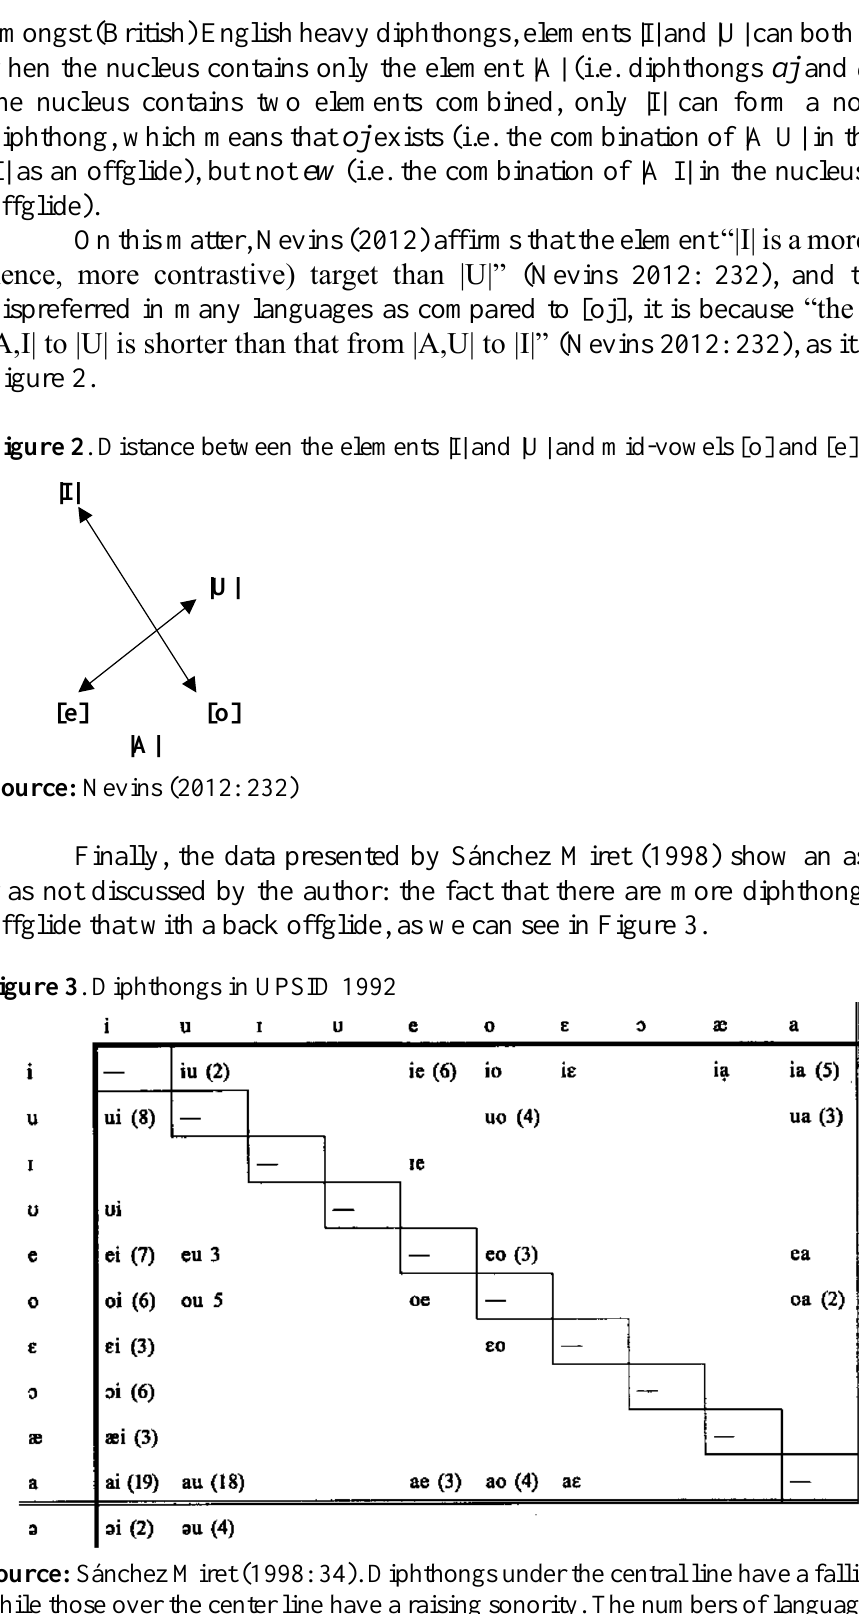
Source: Sánchez Miret (1998: 34). Diphthongs under the central line have a falling sonority, while those over the center line have a raising sonority. The numbers of languages that have each diphthong is presented in